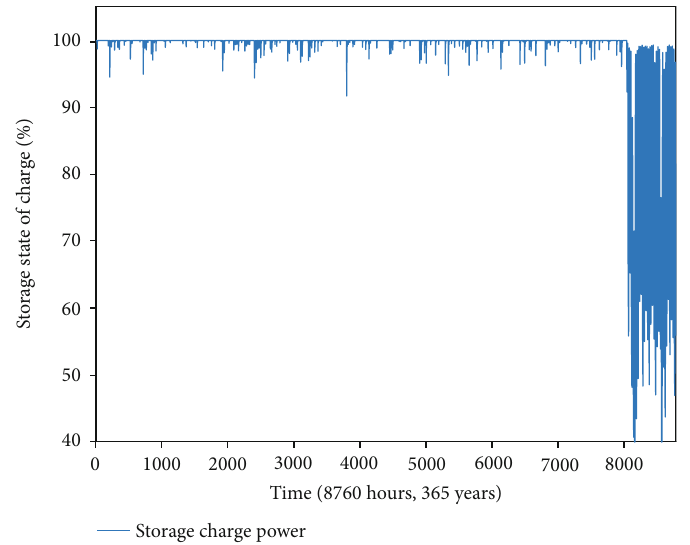
Figure 20: PV storage charge state of the hybrid PV-hydro islanded minigrid